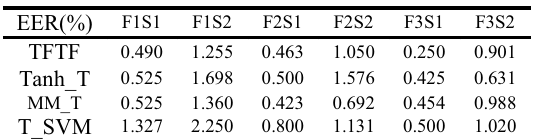
Tab.5. EER comparison between different fusion methods based